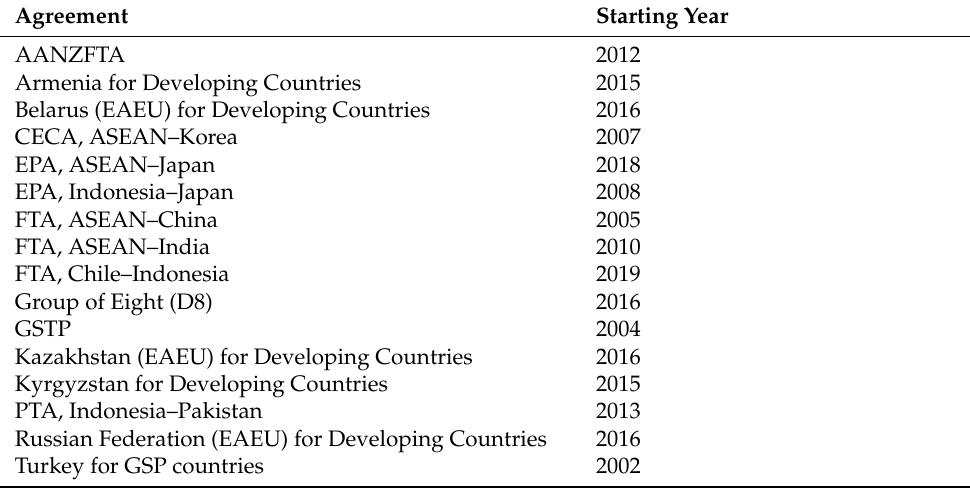
Table A3. Trade Agreements for